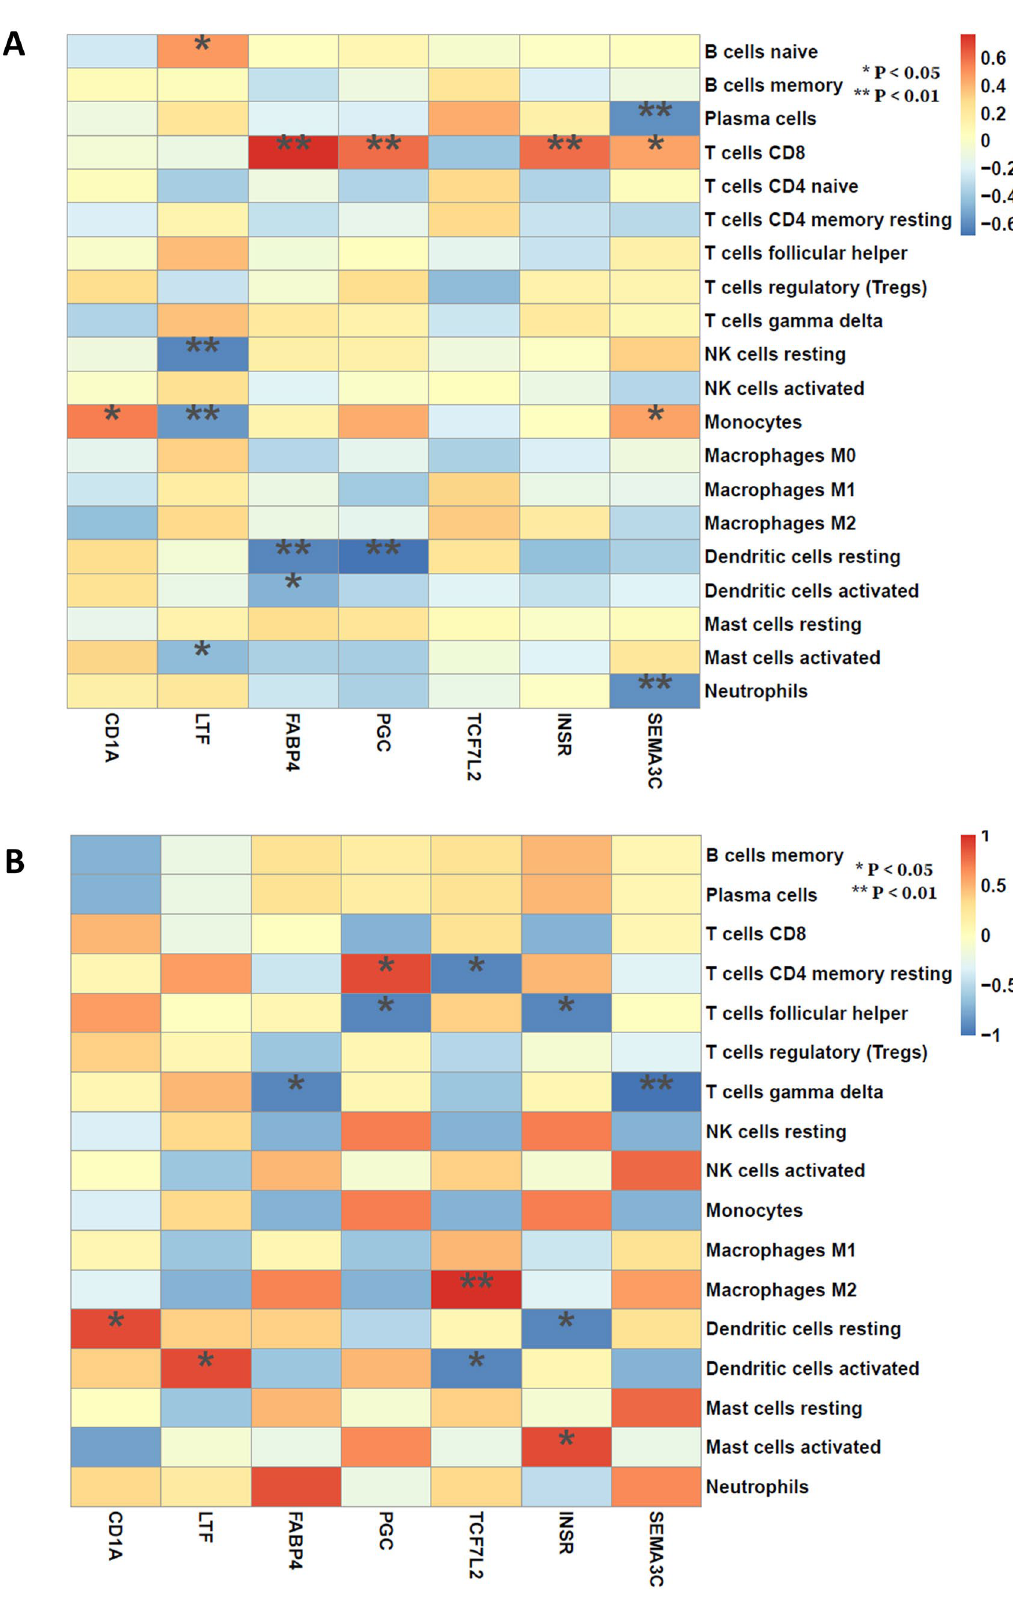
Figure 6. Spearman correlation of the key genes and the immune cells. ( A ) Correlation in BE samples. ( B ) Correlation in NE